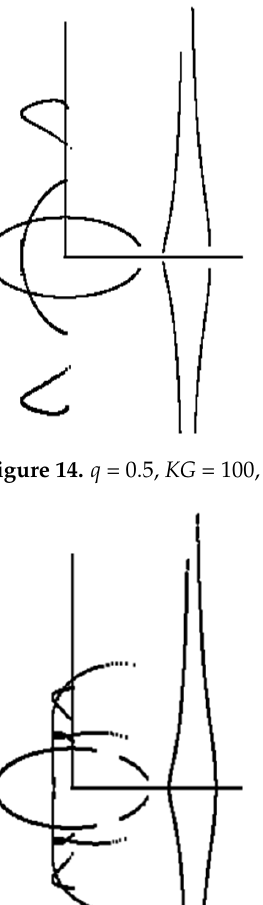
Figure 15. q = 1.5, KG = 80, and DK = 120.